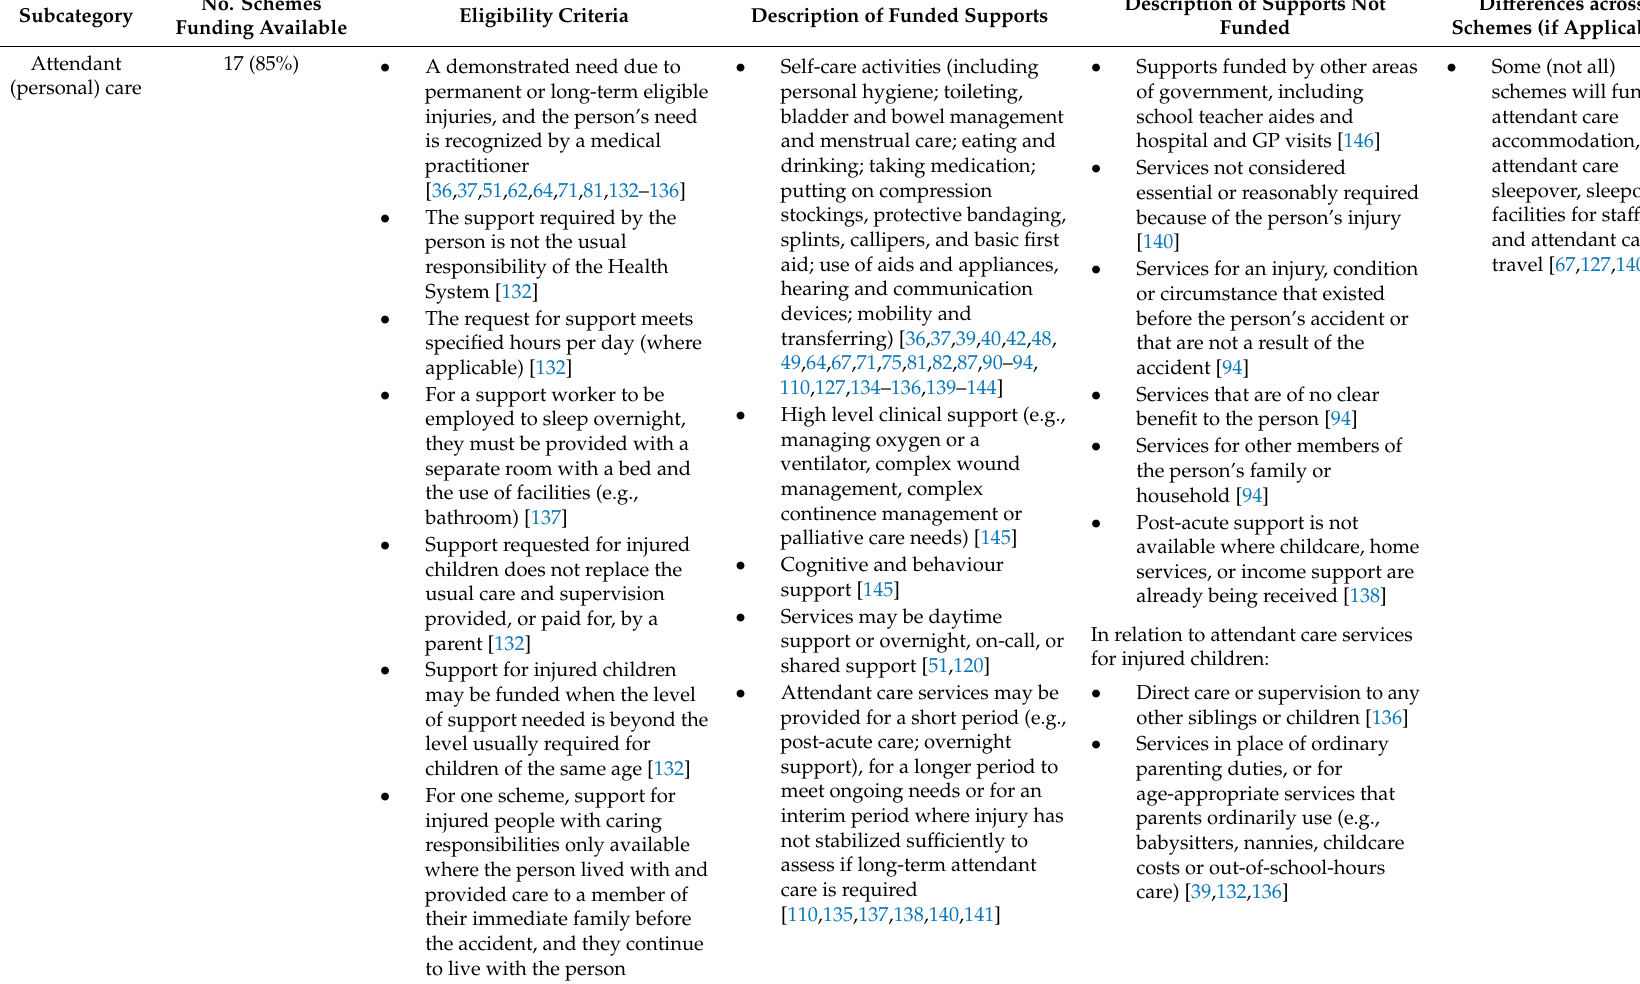
Table 4. A Comparison of Service Delivery Funding across the